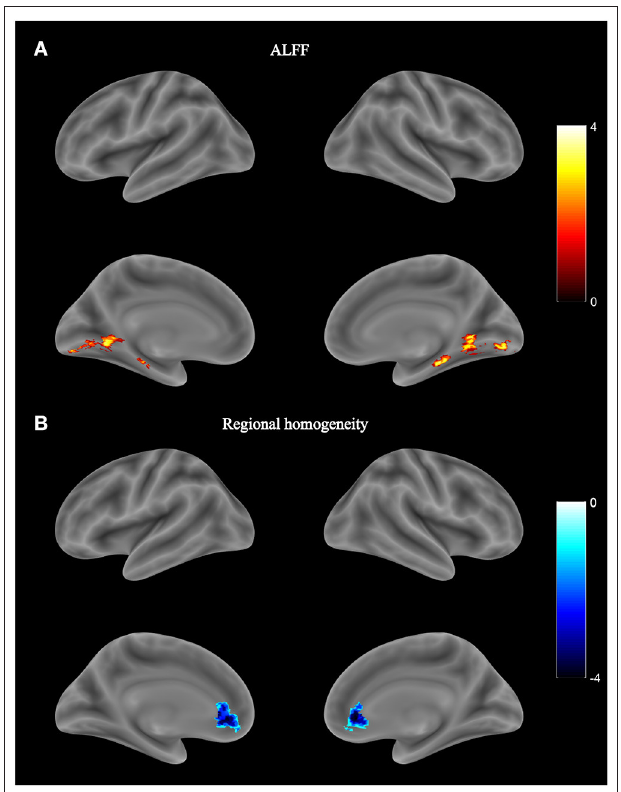
FIGURE 3 | Local functional abnormality in HIV + HoM compared with HIV– HoM. (A) Brain regions with increased amplitude of low-frequency fluctuation (ALFF) values in the HIV + HoM group (voxel-level uncorrected P < 0.005, cluster-level FWE-corrected P < 0.05). (B) Brain regions with decreased regional homogeneity in the HIV + HoM group (voxel-level uncorrected P < 0.005, cluster size > 50). The color bars indicate T -statistics. TABLE 4 | Amplitude of low-frequency fluctuation (ALFF) differences between HIV + HoM and HIV– HoM. Region